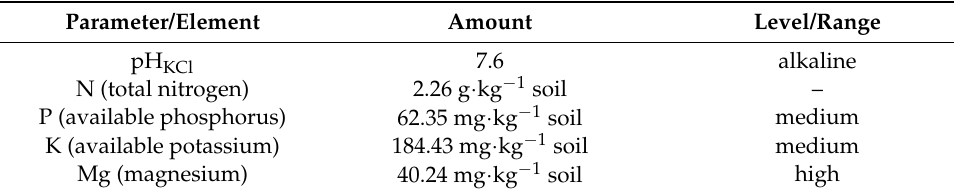
Table 1. Chemical properties of soil in the study